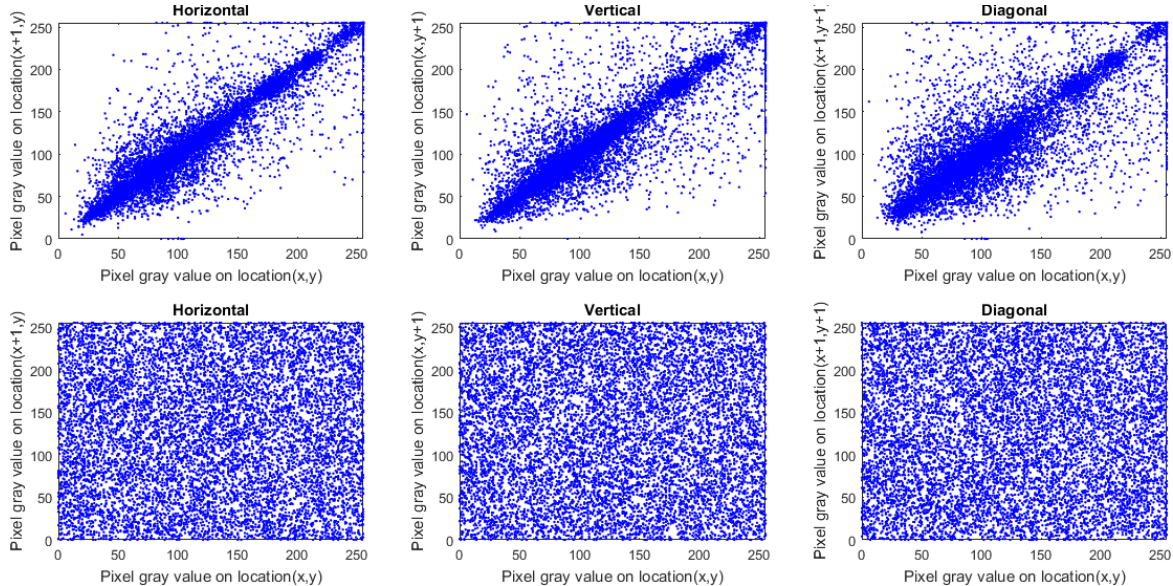
Figure 6. Correlation distribution of plain and ciphered Houses image for the blue